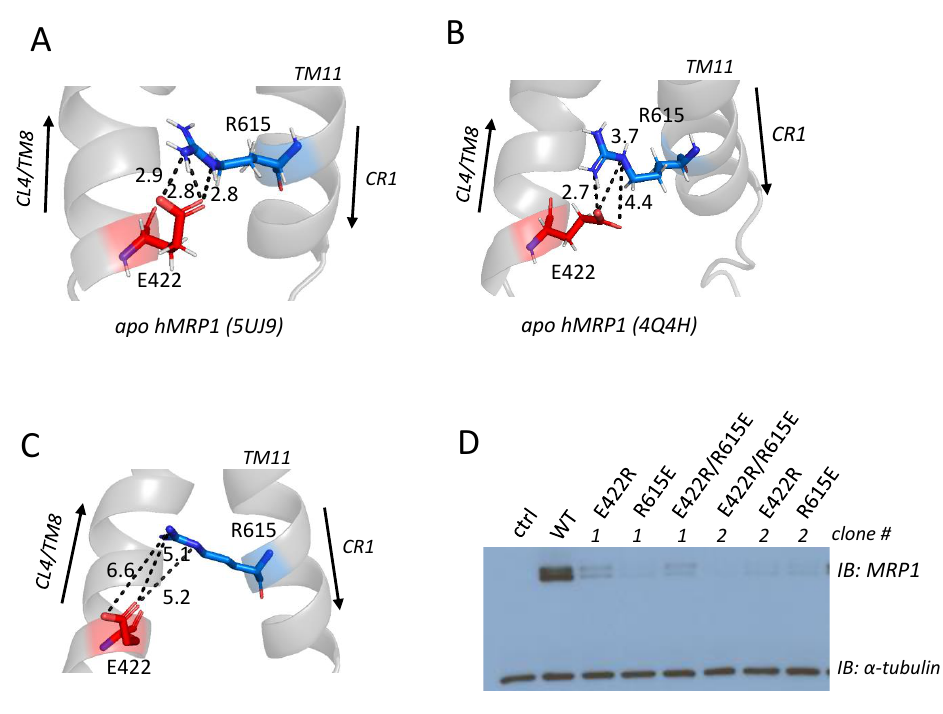
Figure 5. Potential bonding interactions of CL4-Glu 422 and effect of double exchange mutation with CR1-Arg 615 on hMRP1 levels in HEK cells. Shown are three views of the potential electrostatic bonding interactions of the CL4-Glu 422 (red) acidic side chain with the basic side chain of Arg 615 (blue) located in CR1 (between TM11 and NBD1) observed in ( A , B ) the atomic homology models of hMRP1 based on ( A ) the apo bMrp1/Abcc1 cryo-EM structure (PDB: 5UJ9) [14] and ( B ) the apo TM287/288 crystal structure (PDB: 4Q4H) [21]. ( C ) in the apo bMrp1/Abcc1 cryo-EM structure (PDB: 5UJ9) [20]. The distances (in Å) between selected ion pairs (dotted lines) are indicated and were determined using the measuring tool of PyMOL. For further details, see Table S1. ( D ) Shown is a representative 5 s exposure immunoblot of WCE (10 µ g protein per lane) prepared from HEK cells transfected with expression vectors encoding wild-type (WT) and two independent clones (# 1 & 2) of mutant (E422R, R615E, and E422R/R615E) hMRP1. A WCE of untransfected HEK cells served as a negative control (ctrl). hMRP1 was detected with Mab QCRL-1 and anti- α -tubulin was used as a protein loading